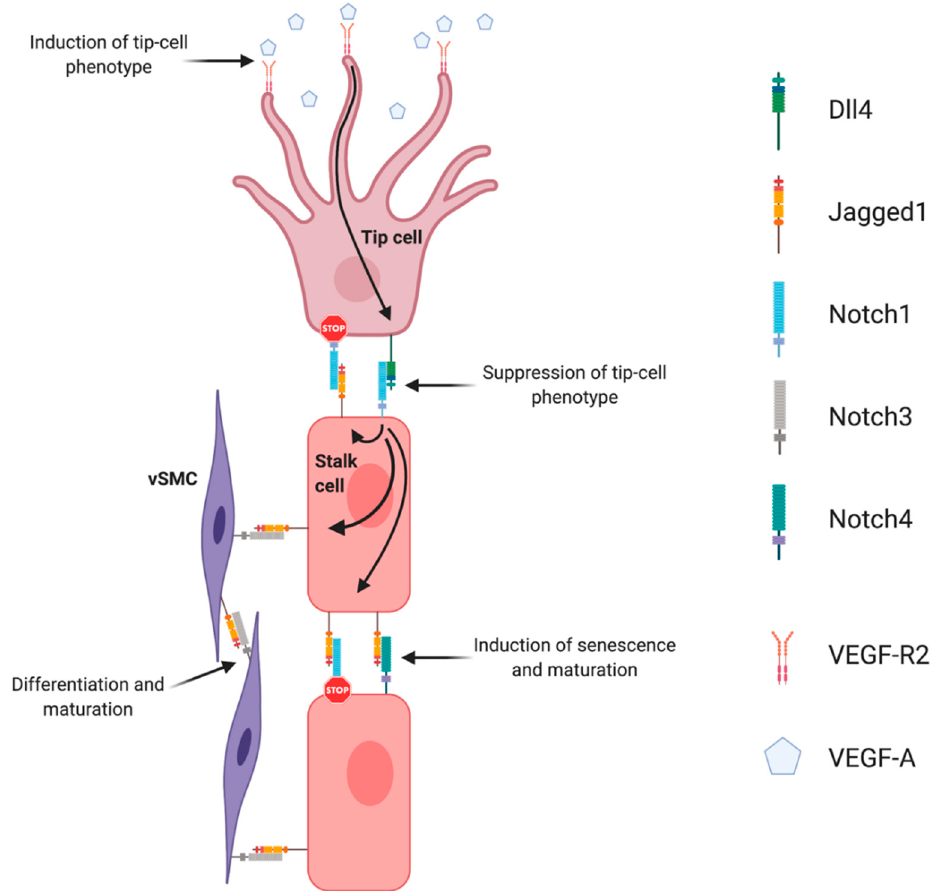
Figure 2. Notch signaling regulation of angiogenesis. Endothelial Dll4, mainly expressed in tip cells, activates Notch1 in adjacent stalk cells leading to the up-regulation of endothelial Jagged1. Jagged1 antagonizes Dll4 ability to bind to activate Notch1 in tip cells, creating a negative feedback loop in the regulation of endothelial branching. Endothelial Jagged1 positively regulates vascular maturation by two possible mechanisms: by activating endothelial Notch4 in stalk cells and Notch3 in vascular smooth muscle cells (vSMC).